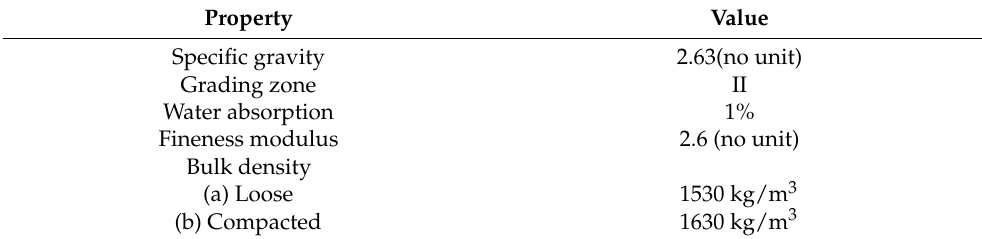
Table 2. Physical properties of fine aggregate.